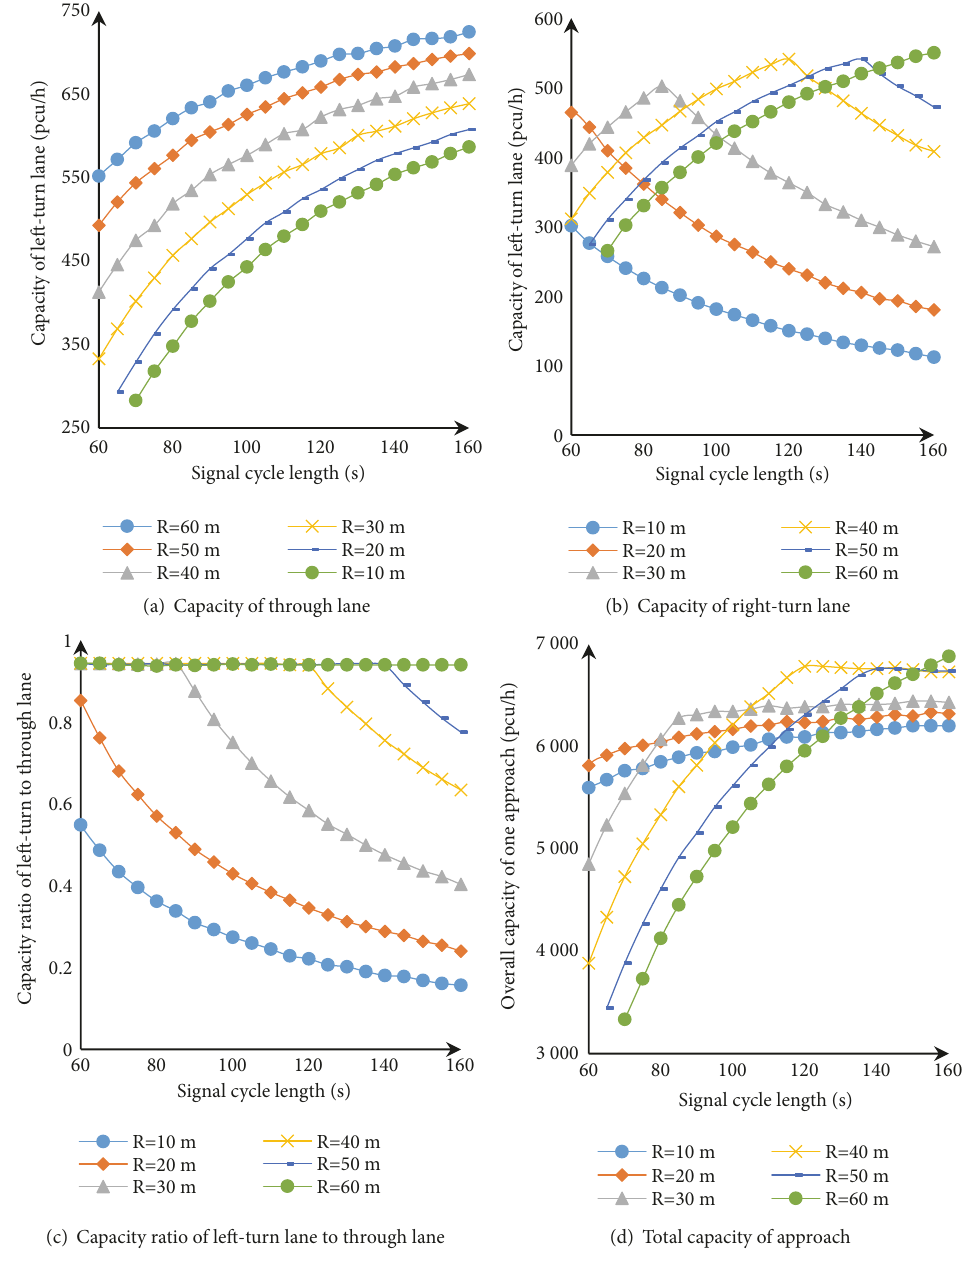
Figure 6: The sensitivity analysis